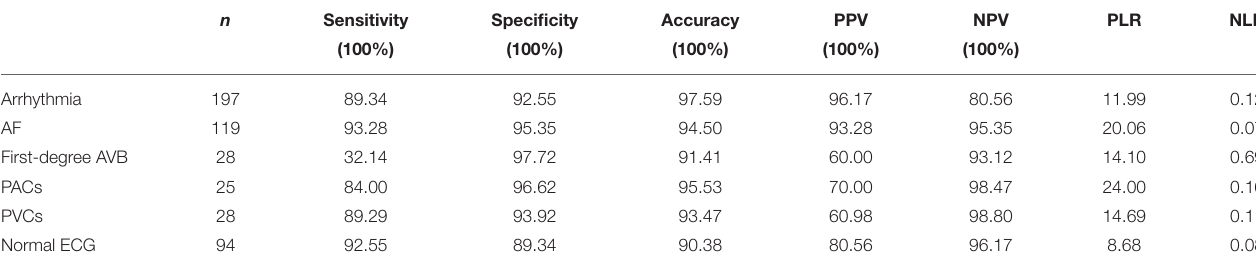
TABLE 2 | Diagnostic accuracy of AMAZFIT ® against ECG.